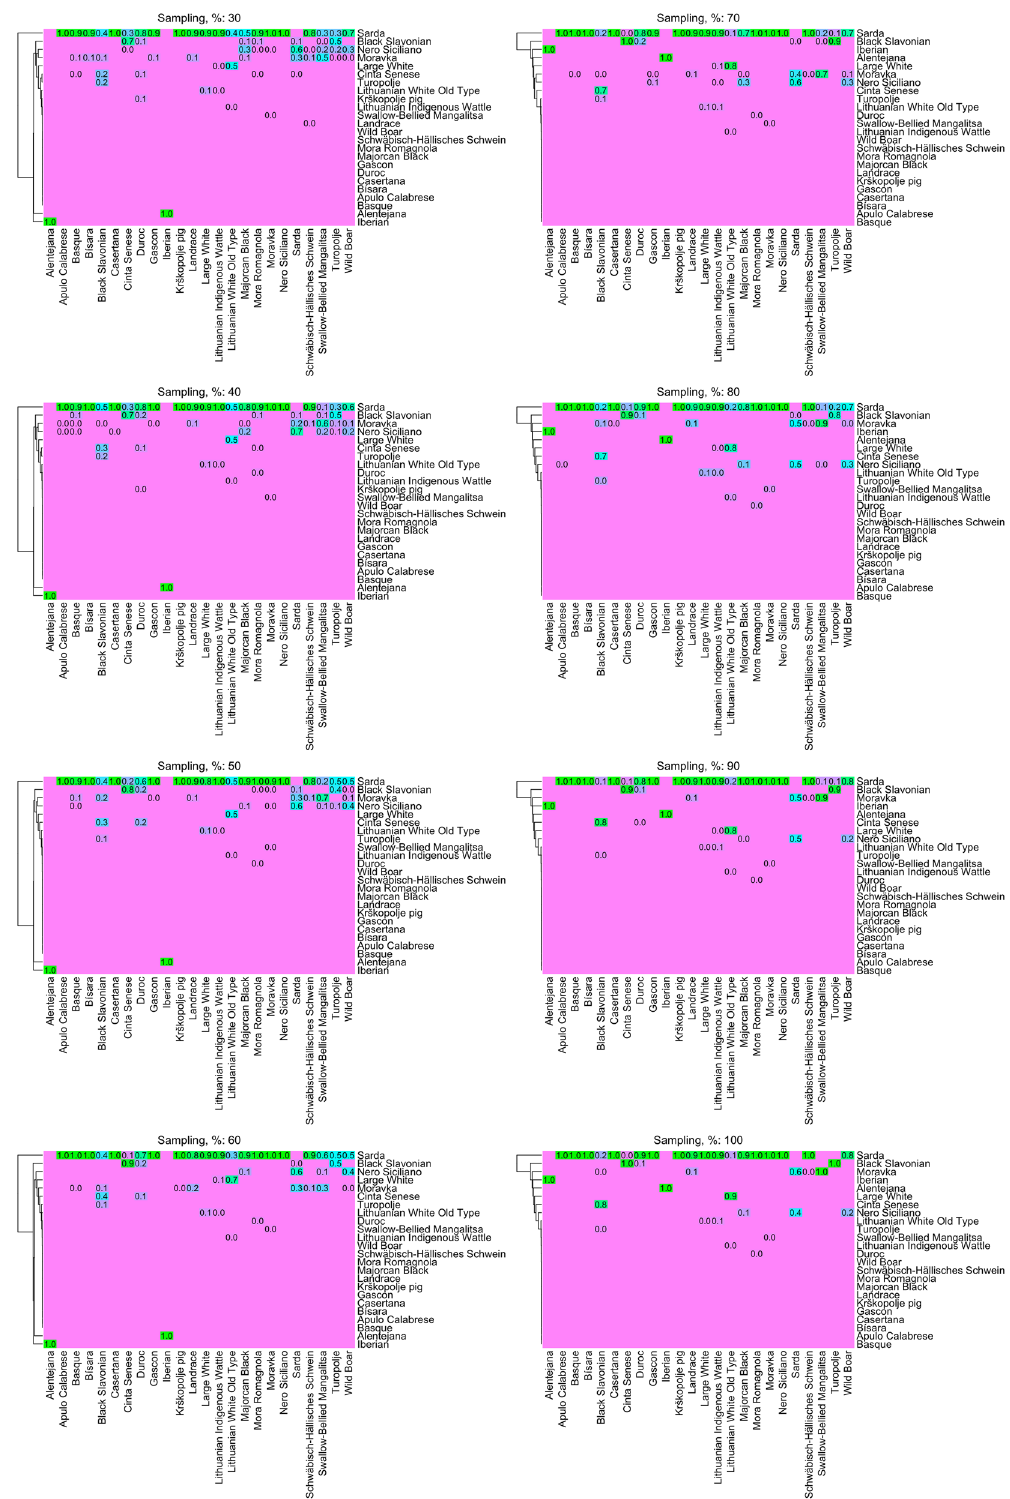
Figure 6. Heatmaps of the DAPC assignment in the un-supervised scenario, in increasing sample size, of percentage of external assignment per breed (in a scale of 0 to 1); x-axes show the observed and y-axes the predicted breed. Heatmaps were constructed using the R 36 package ComplexHeatmap 38